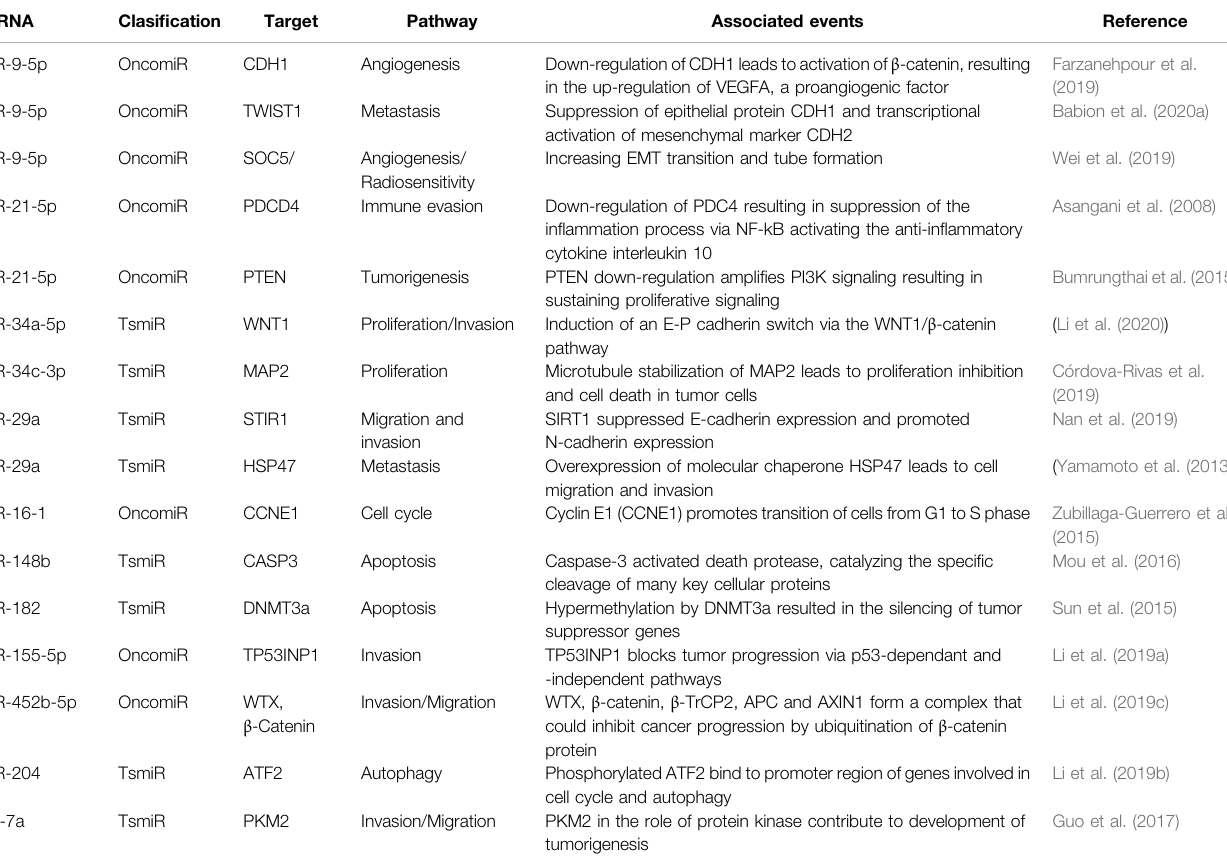
TABLE 2 | Relevant target genes for dysregulated miRNAs in cervical cancer.